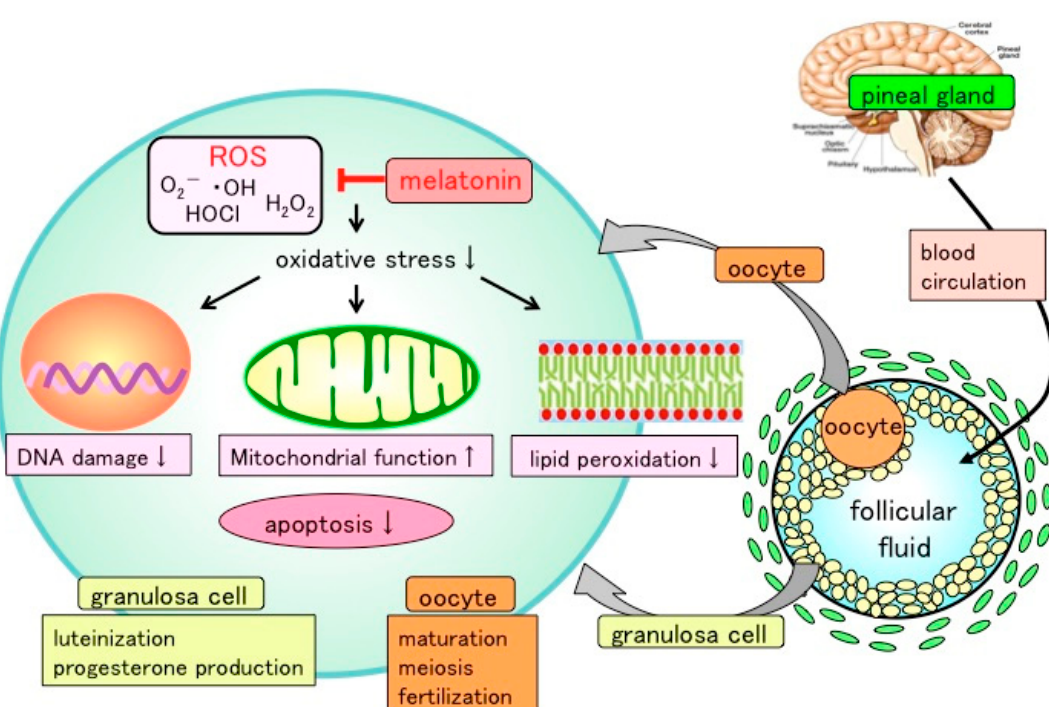
Figure 1. Presumed action of melatonin in ovarian follicle. Melatonin, secreted by pineal gland, is taken up into the follicular fluid from the blood. Reactive oxygen species (ROS) produced within the follicles, especially during the ovulation process, are scavenged by melatonin. Excess amounts of ROS may be involved in oxidative stress of oocyte and granulosa cells. Melatonin reduces the oxidative-stress-induced DNA damage, mitochondrial dysfunction, lipid peroxidation, and apoptosis of granulosa cells, showing that melatonin protects these cells by reducing free radical damage of cellular components including nuclei, mitochondria, and plasma membranes. The balance between ROS and antioxidants (melatonin) within the follicle may be critical for oocyte maturation, meiosis, and luteinization of granulosa cells.